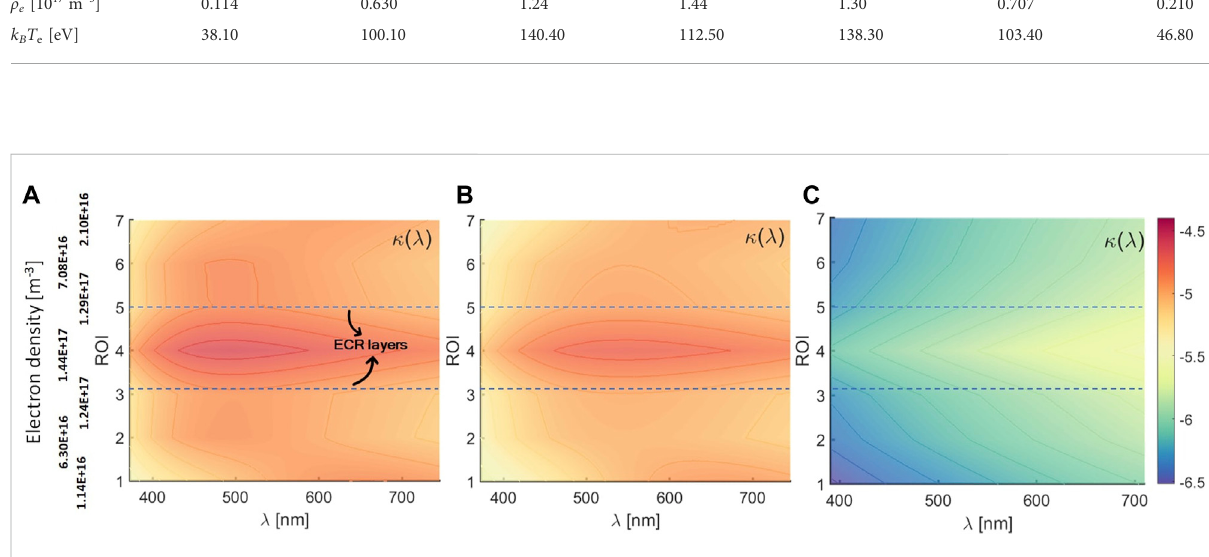
FIGURE 9 Numerical opacity κ ( λ ) [cm 2 g − 1 ] (log scale) of argon plasma in the VIS range, as resulting from NLTE CR calculations in FLYCHK, for (A) unperturbed self-emitting plasma, and plasma perturbed by an external black-body radiation fi eld [erg m − 2 s − 1 Hz − 1 ] at 8000 K, with smaller (B) and larger (C) intensities.Opacityisshowninthewavelength λ [nm]-n.ROI(electrondensity ρ e [m − 3 ])plane.TheROIn.labelincreasesuponmovingfrom negative to positive z-axis position along the longitudinal z-axis of numerically simulated plasma , as described in Section 2.3.1 and shown in Figure 3. ECR layers are shown (blue-dashed